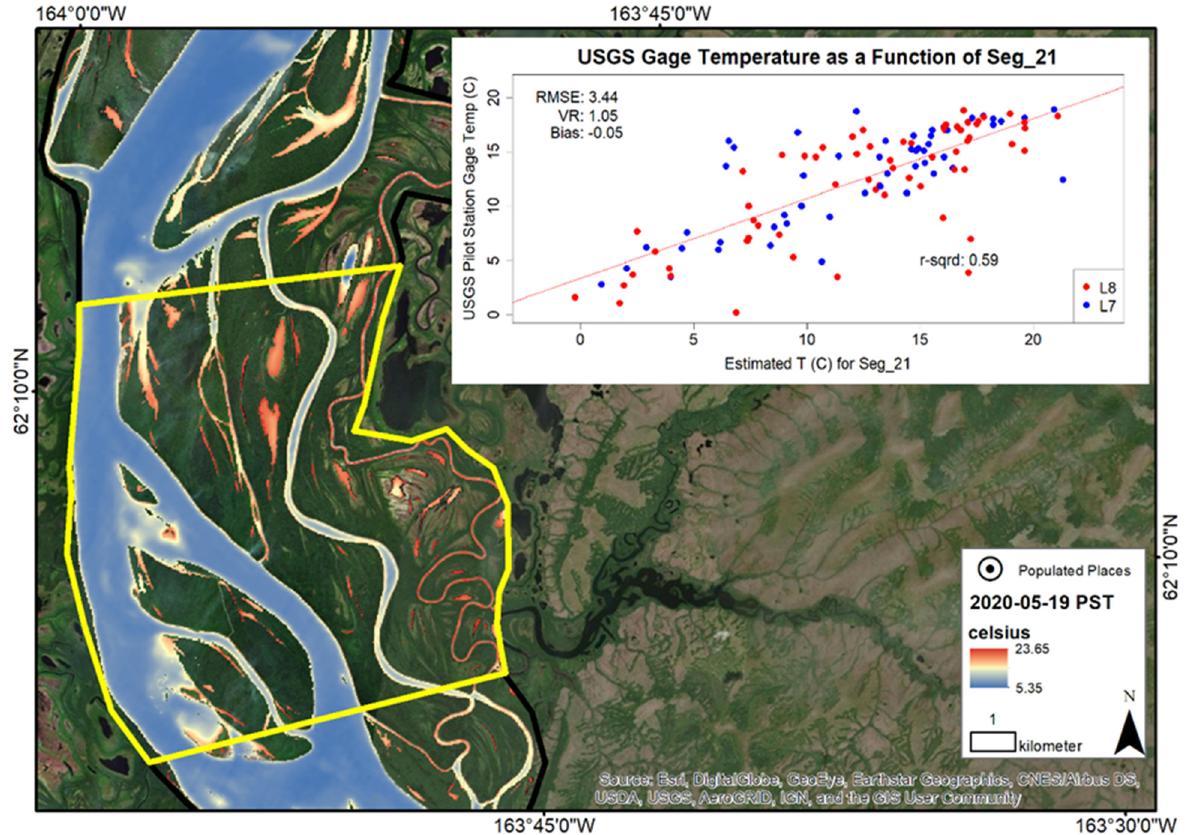
Figure A19. The Yukon River is divided into multiple channels in segment 21. The main stem lies further west and flows through a long meander in a northerly direction. This main channel is divided by islands whose size fluctuates with river stage. To the east, a large slough (Patsy’s Slough) meanders north. This slough is large enough to maintain the cooler water temperatures similar to those in the main stem. Furthest east is the Azacharum Slough. This slough has broader meanders and warmer estimated water temperatures. Other minor sloughs, channels, and surface water are featured in this segment during high river stages. The pST is 100% with no NoData gaps. This segment features the poorest correlation of all river segments (RMSE = 3.44°C, r 2 = 0.591).